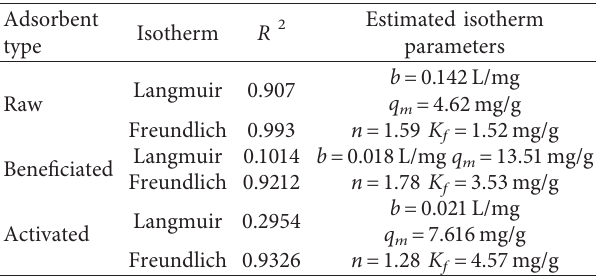
Table 4: Isotherm parameters obtained from isotherm graphs for all adsorbents.